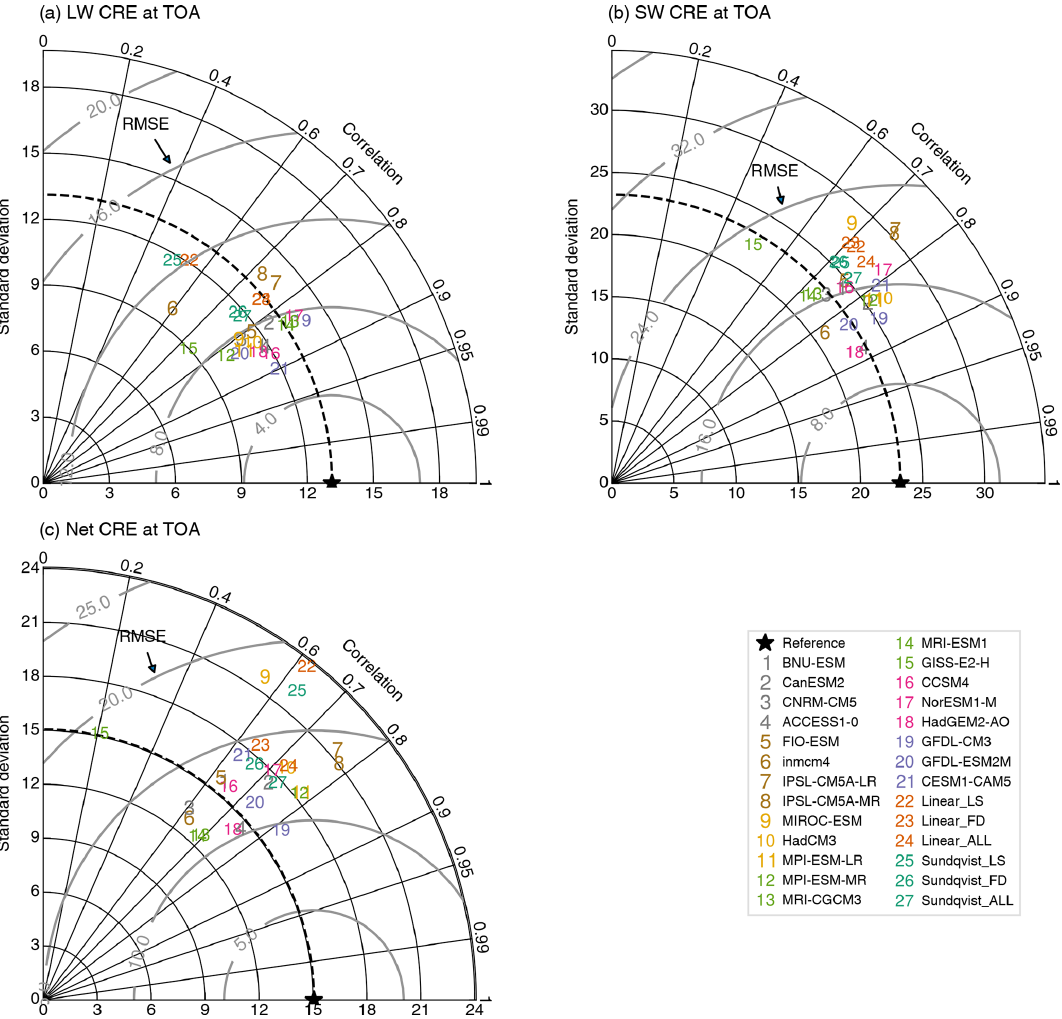
Figure 18. Taylor diagrams showing standard deviation (Wm − 2 ), root-mean-square error (RMSE; Wm − 2 ) and spatial pattern correlation for the observed and simulated (a) LW, (b) SW and (c) net CREs at TOA in CMIP5 models and Isca simulations (LS, FD and ALL). The statistics of these variables are calculated based on annual mean data, where the monthly data (1996–2005) from historical simulation are used for analysis of CMIP5 models. The observed field is as a reference and denoted by a black star. Contour of the standard deviation from the observed field is shown by the dashed black line, and the contours of the RMSE are displayed in gray with labels. Table 4. Global and annual mean climatology from parameter sensitivity tests. In each test, only the parameter listed in the table header (see Table 1) is changed from the default values. The units for cloud effective radius ( r e ) and in-cloud liquid water mixing ratio ( w l ) are µ m andgkg − 1 ,